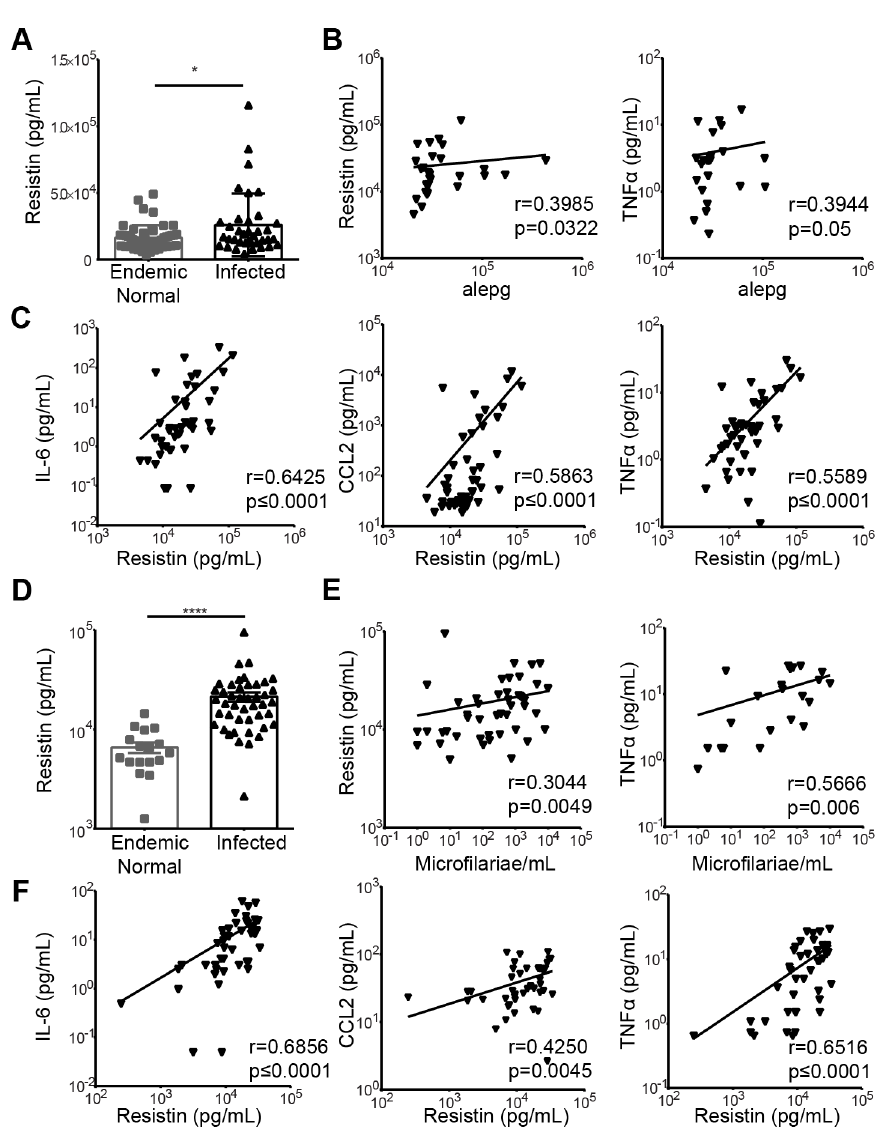
Fig. 8. Expression of resistin in human patients infected with STH or filarial nematodes. (A) Serum resistin from uninfected (n=51) or STH- infected children (n=49) was measured. (B) The fecal egg burdens in infected children was quantified as A. lumbricoides eggs per gram feces (alepg) and plotted against serum resistin and TNF a . (C) Proinflammatory cytokines were positively correlated with resistin in the serum of STH-infected children. (D) Serum from uninfected endemic normal individuals (n=17) or patients infected with Wuchereria bancrofti (n=44) was analyzed by ELISA for resistin. (E) In infected individuals, a positive correlation was observed between the circulating microfilariae and resistin or TNF a . (F) Proinflammatory cytokines were positively correlated with resistin levels in the serum of infected